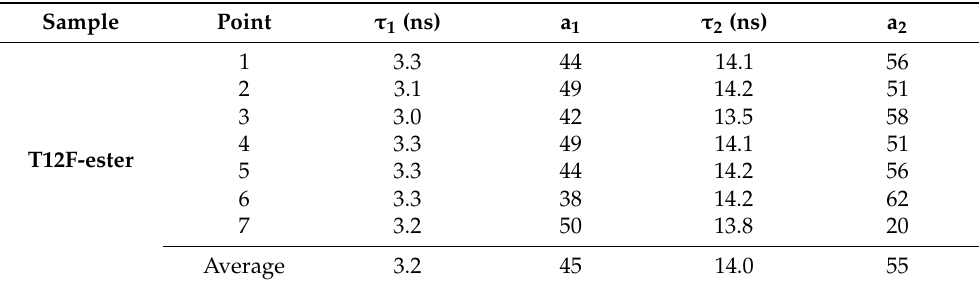
Table 4. Values of time constants ( τ i ) and normalized (to 100) pre-exponential factors (a i ) obtained from the fit of the emission decays collected at the selected points of T12F-ester (Figure 5). The errors in the time constant values are about